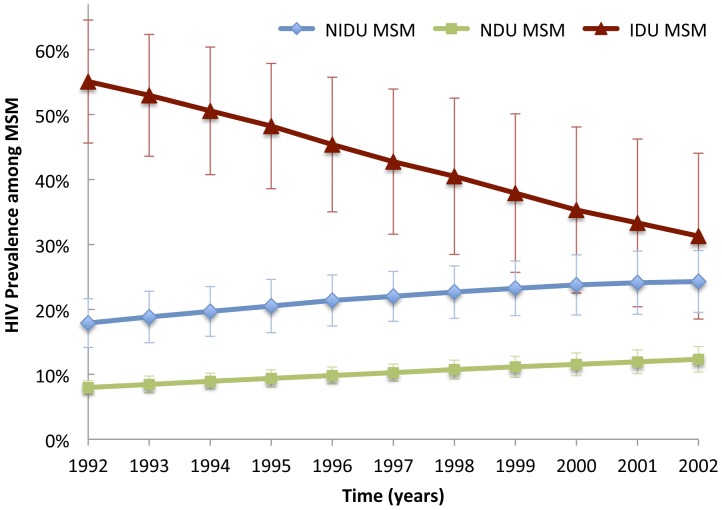
HIV prevalence among MSM agents obtained from a Monte Carlo simulation of the agent-based model, stratified by drug user status.Error bars represent two standard deviations of the bootstrap estimates. Abbreviations: MSM = men who have sex with men; NU = non-drug user; NIDU = non-injection drug user; IDU = injection drug user.